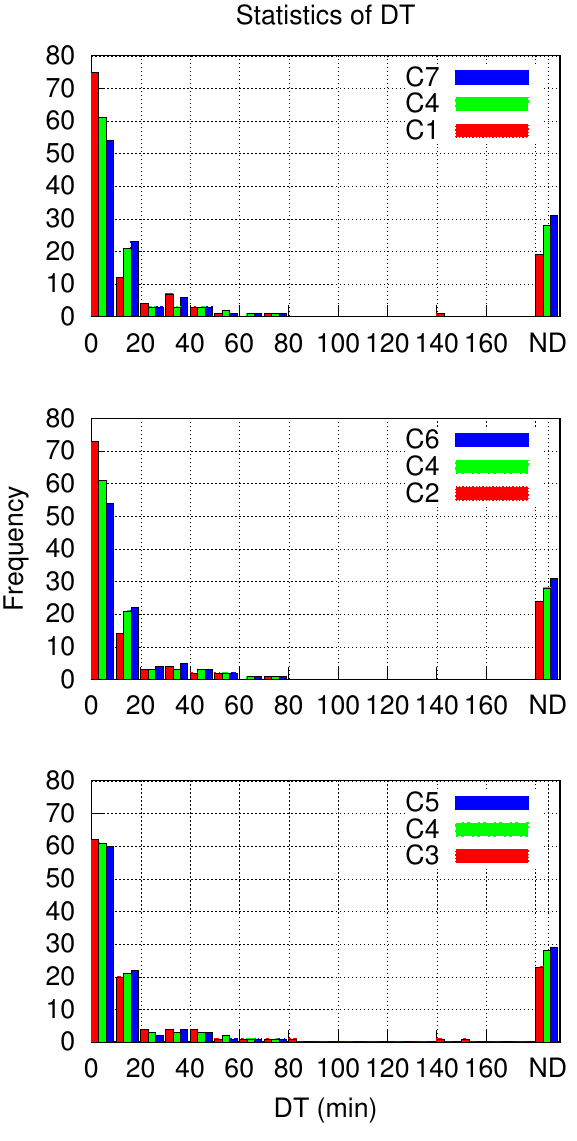
Fig. 12. Frequency histograms of the delay times DT for the 7 con- figurations applied in the sensitivity test. The reference configura- tion C4 is shown in all three graphs in green. On the right side of the graphs the frequencies of the no-detection cases (ND) are also